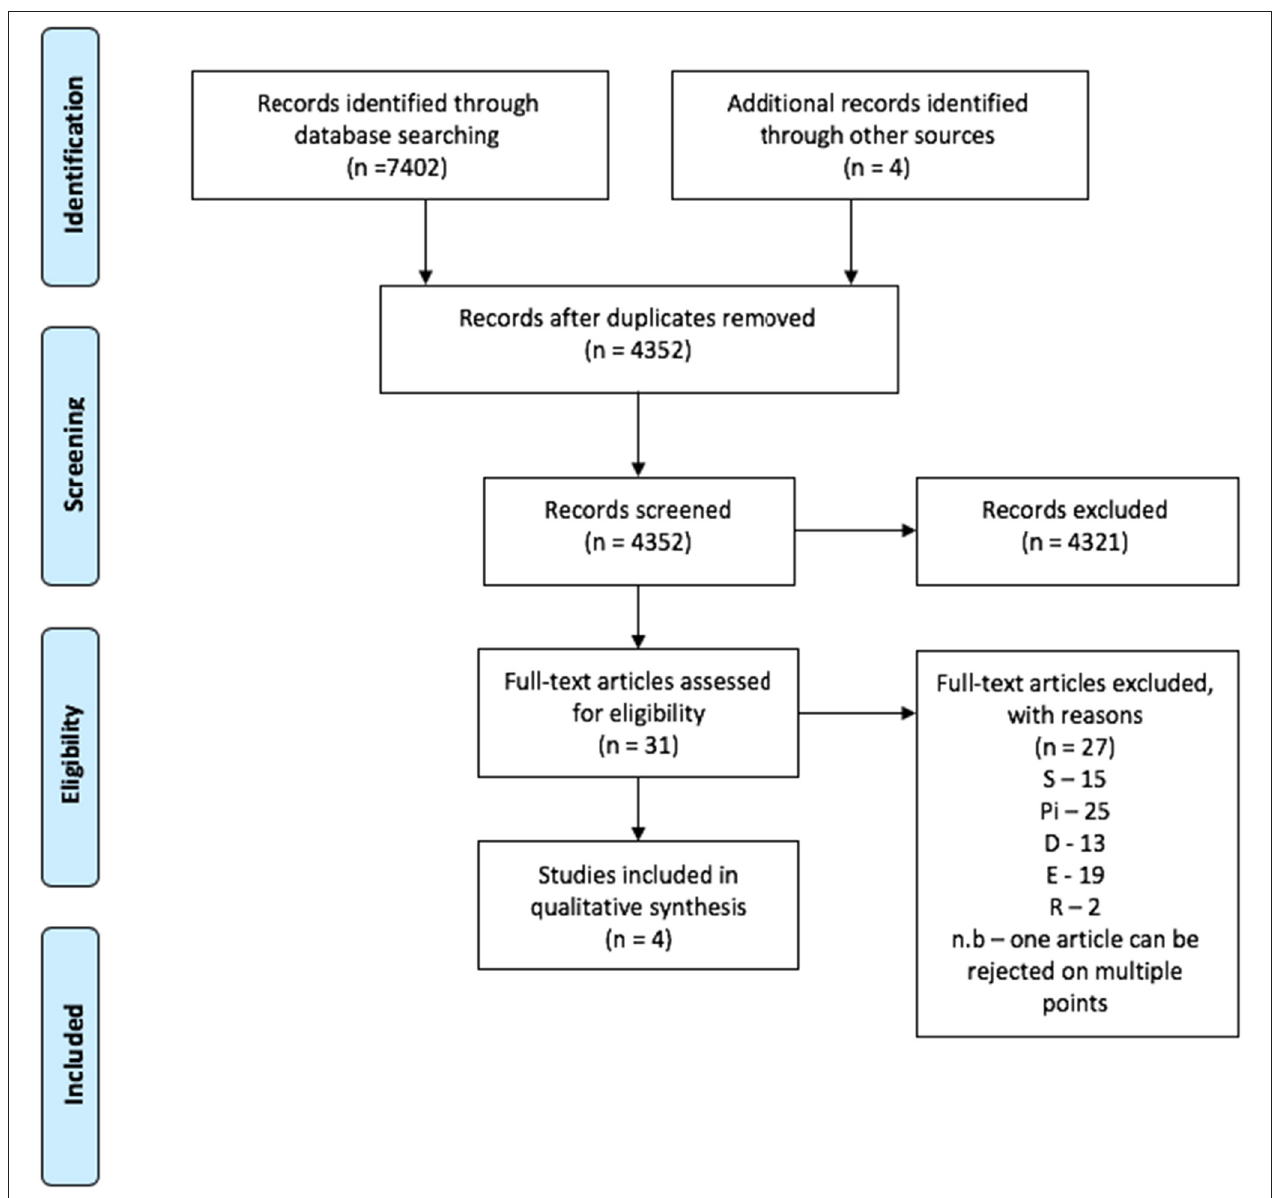
FIGURE 2 | Prisma flow chart for inclusion of articles for Search